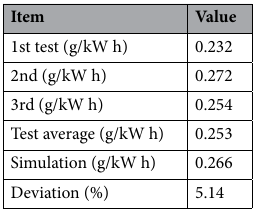
Table 3. Oil consumption